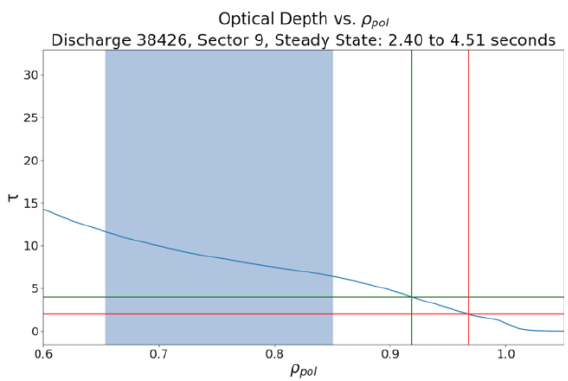
Fig. 2. The optical depth (  ) at each location in the plasma measured by the CECE diagnostic (highlighted region) is tracked by the analysis method. Higher optical depth minimizes the impact of density fluctuations on CECE measurements [5, 17]. The red and green lines denote optical depth levels of 2 and 4, respectively.